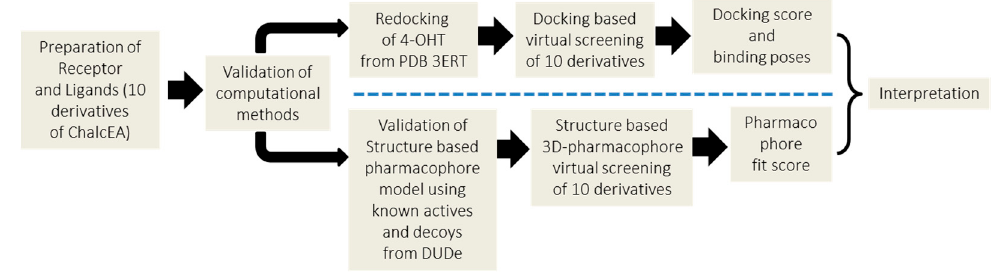
Figure 8. The general scheme of methodologies in the present work.